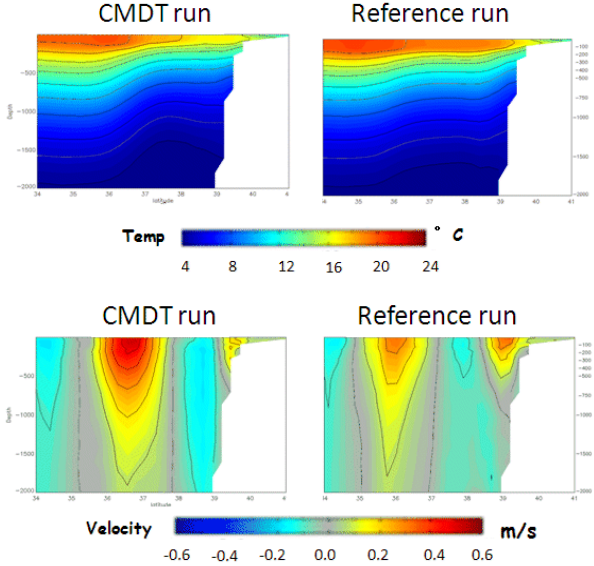
Figure 5: Cross section of temperature (top) and zonal velocity (bottom) at 72°W longitude in the CMDT run (left) and the reference run (right). Fig. 5. Cross section of temperature (top) and zonal velocity (bot- tom) at 72 ◦ W longitude in the Mercator CMDT run (left) and the reference run